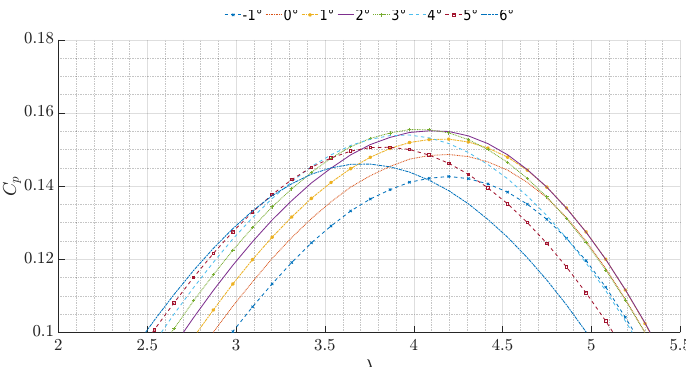
Figure 24. Effect of wing pitch angle on C p vs. λ